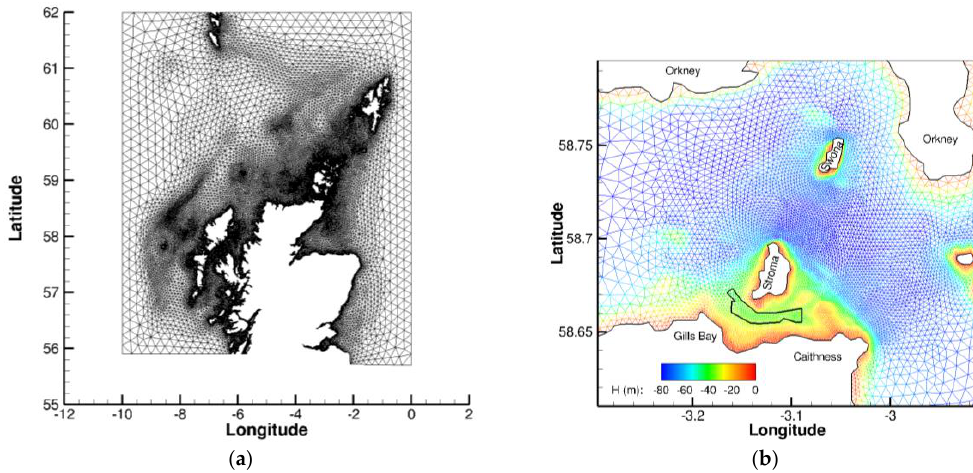
Figure 2. The unstructured mesh for the model: the whole domain ( a ) and the Inner Sound between Stroma and Caithness ( b ), with the mesh coloured according to water depth H (m). The Meygen lease area is outlined.